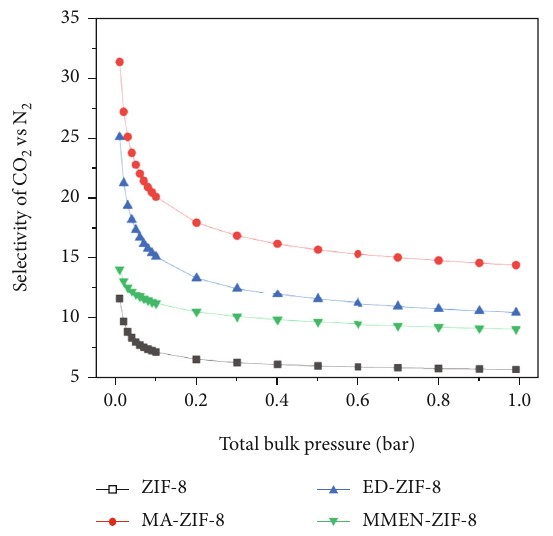
Figure 8: The IAST-predicted selectivities for equimolar CO N at 298K as a function of total bulk 2